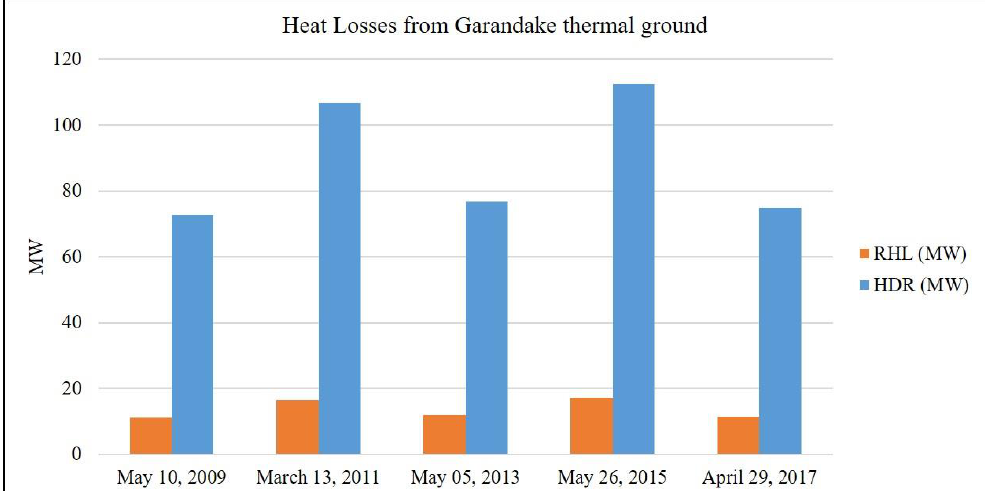
Figure 9. Changes in total radiative heat loss and heat discharge rates from the Mt. Garan fumaroles from 2009 to 2017.